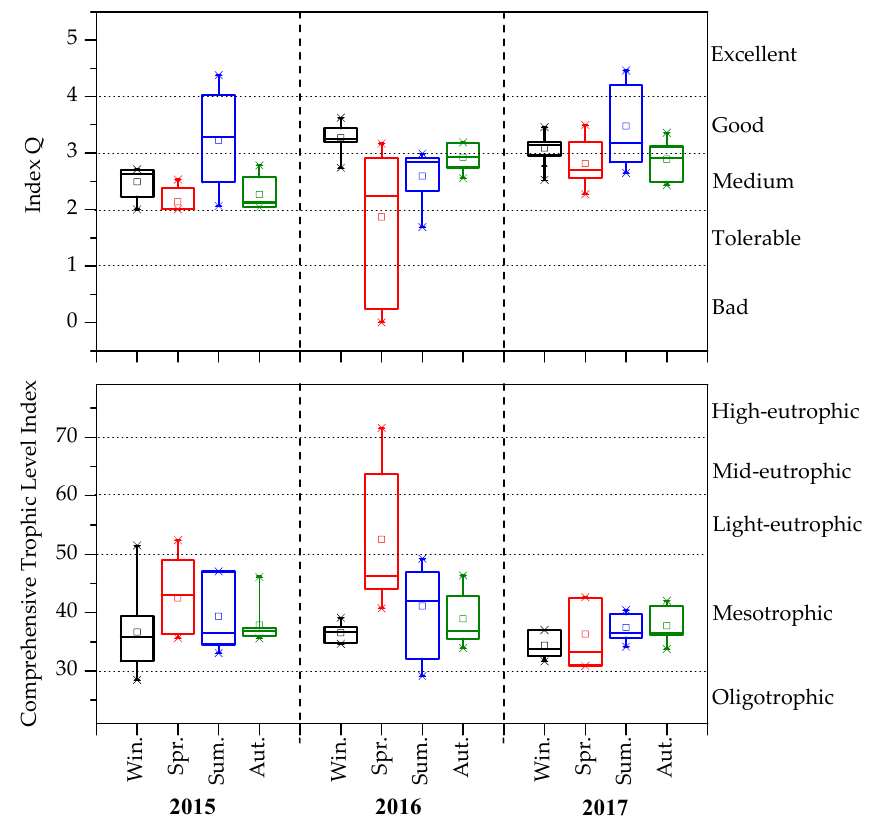
Figure 4. Evaluation of the ecological status of Gaozhou Reservoir from 2015 to 2017 based on the Q and TLI( Σ ) indexes.